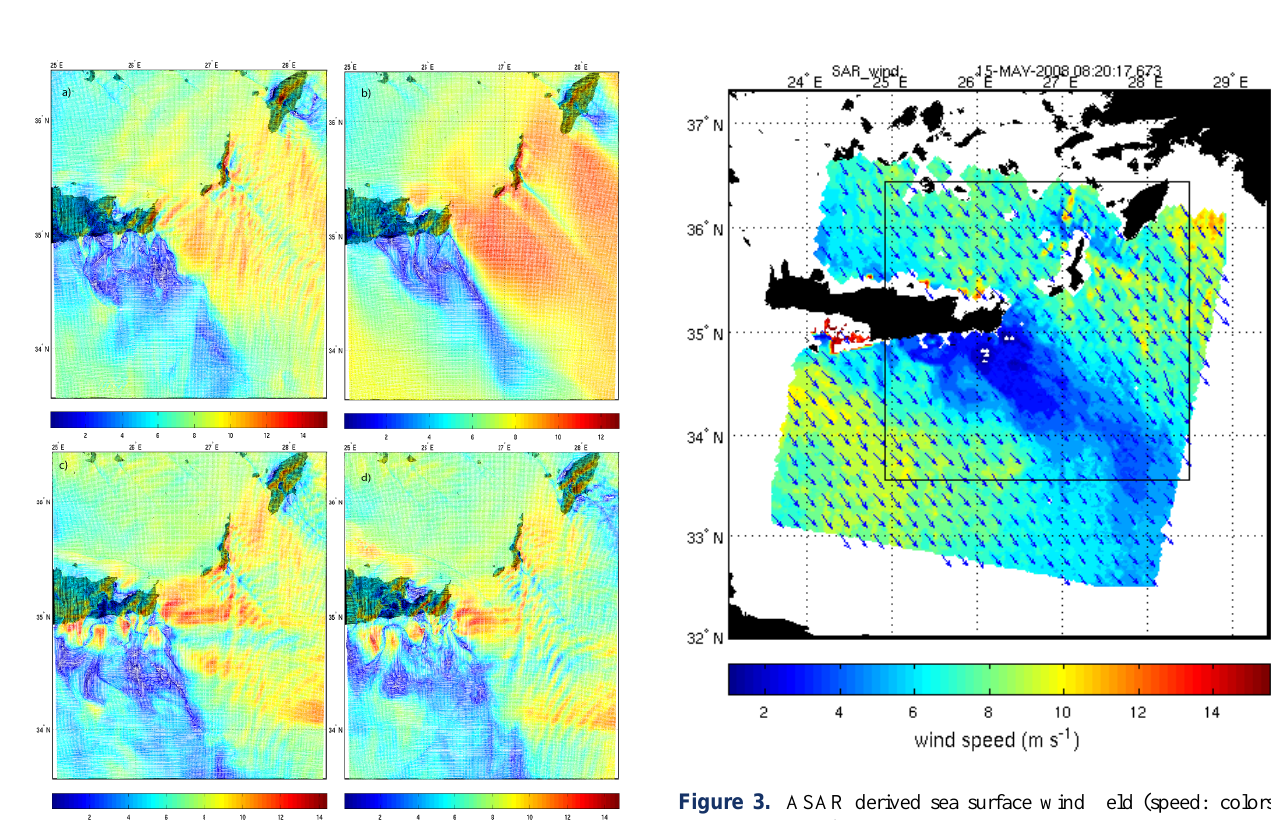
Figure 3. ASAR derived sea surface wind field (speed: colors; direction: arrows) at 08:20UTC, 15 May 2008. The position of the WRF inner domain is represented with the black